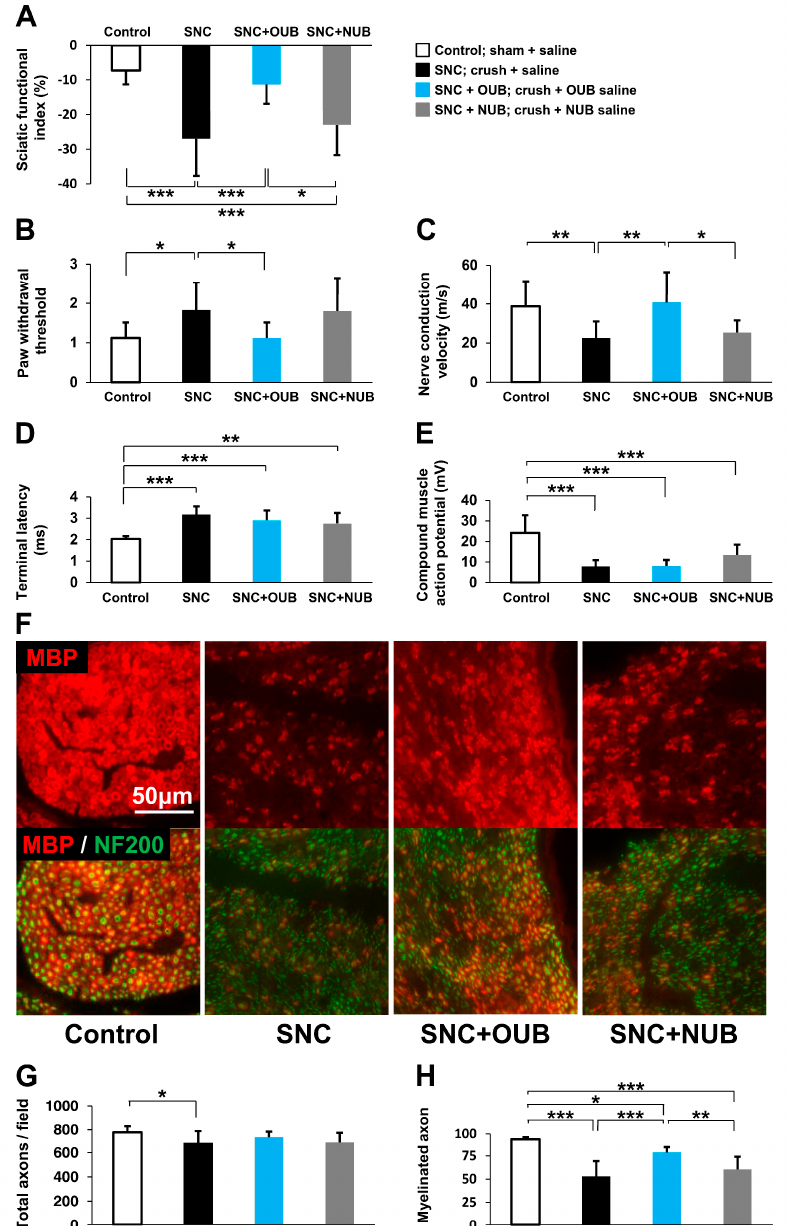
Figure 1. Oxygen ultra-fine bubbles (OUBs) improve dysfunction after sciatic nerve crush injury in rats. ( A – E ) Sciatic functional index analysis ( A ), von Frey filament test ( B ), and electrophysiological analysis ( C ); nerve conduction velocity ( D ); terminal latency ( E ); compound muscle action potential were performed 4 weeks after sciatic nerve crush injury in each group (Control, SNC, SNC+OUB, SNC+NUB); ( F ) representative fluorescence micrographs of cross-sectional slices of sciatic nerves labeled for MBP (red) and NF200 (green) 4 weeks after operation. Scale bar = 50 μ m; ( G ) quantification of total axons (NF200-positive axons) per field; ( H ) quantification of myelinated axons (MBP-positive axons) per total axons (NF200-positive axons). Significance was determined by one-way ANOVA followed by Tukey–Kramer HSD test. Graphs show mean ± SD. ( n = 11 for the control group, n = 15 for the SNC group, n = 11 for the SNC+OUB group, and n = 8 for the SNC+NUB group). * p < 0.05, ** p < 0.01, *** p < 0.001. OUBs: oxygen ultra-fine bubbles, SNC: sciatic nerve crush injury, NUB: nitrogen ultra-fine bubble, MBP: myelin basic protein, NF200: neurofilament 200.